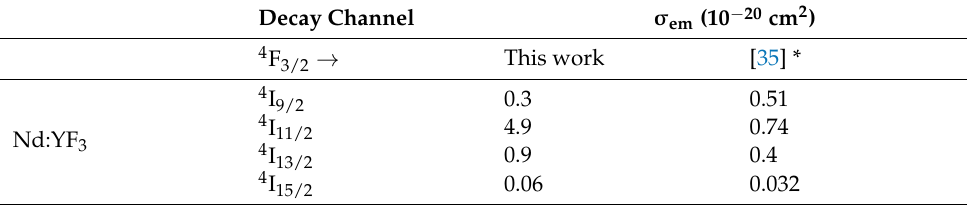
Table 5. Emission cross-sections of Nd:YF 3 .